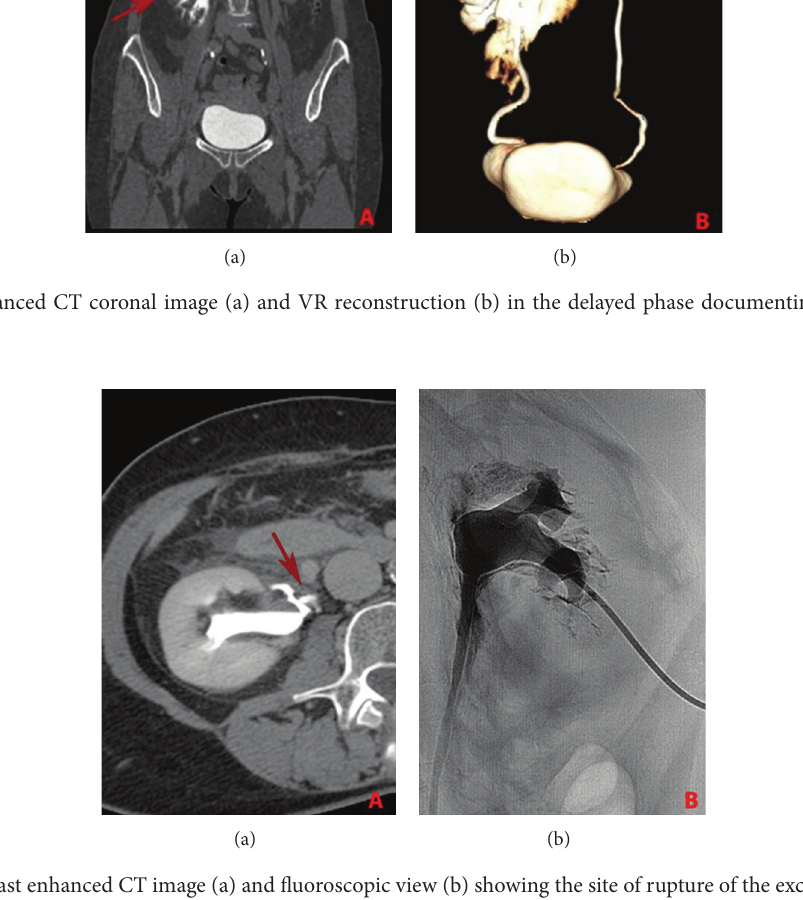
Figure 2: Axial contrast enhanced CT image (a) and fluoroscopic view (b) showing the site of rupture of the excretory system